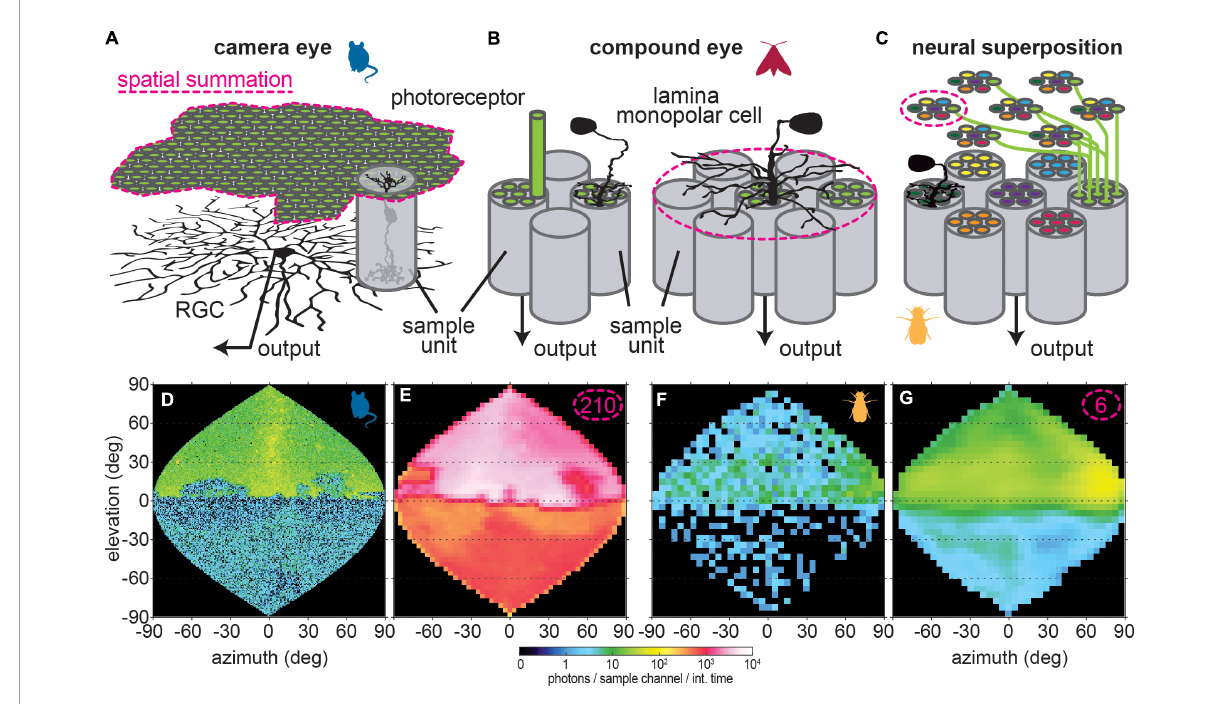
FIGURE4 Different types of spatial summation. (A) Spatial convergence in the vertebrate retina occurs in two stages: photoreceptors signals are pooled by bipolar cells ( sample unit ), which in turn are integrated by retina ganglion cells (RGC), which transmit visual information to the brain. Note that the tiling of RGCs differs from the of bipolar cells, thus resulting in an altered sampling base after spatial summation. (B) In most insects, photoreceptors from one ommatidium of the eye ( Figures 2B,C ) project as a combined sample unit to a single cartridge in the lamina, where lamina monopolar cells (LMC) integrate their information and relay it to the next brain area. Particularly in nocturnal insects, LMCs with lateral processes that extend into neighboring cartridges can thus pool information across sample units, and perform spatial summation as a result. Note that the tiling of these LMCs corresponds to that of the photoreceptors, so that the spatial sampling base does not change when LMCs sum information in space. (C) The neural superposition eyes of Diptera possess a special organization to integrate information spatially: the photoreceptors in each of their ommatidia view different points in space, as represented here by different colors for photoreceptors in each ommatidium. In neighboring ommatidia, one receptor each views the same point in space (same color code). These receptors project to the same cartridge in the lamina, so that the lamina units represent on “pixel” of the image. This way, light representing this “pixel” is focused by six neighboring facets. Neural summation of information across neighboring sample units takes place by integrating information from the photoreceptors in one ommatidium. (D) The same starlight scene as in Figure 1A viewed through a mouse eye without and (E) with spatial summation. (F) Same moonlit scene as in Figure 3A viewed through a fruitfly eye without and (G) with spatial